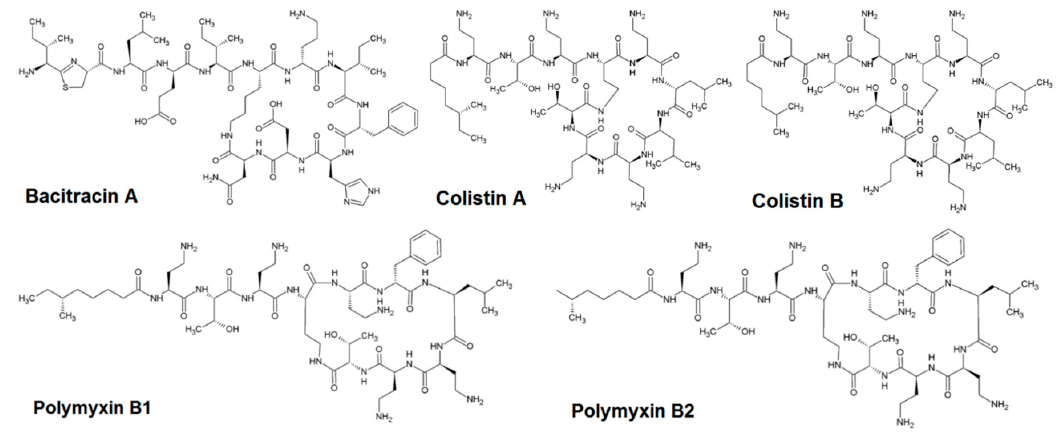
Figure 1. Chemical structures of polypeptide antibiotics.